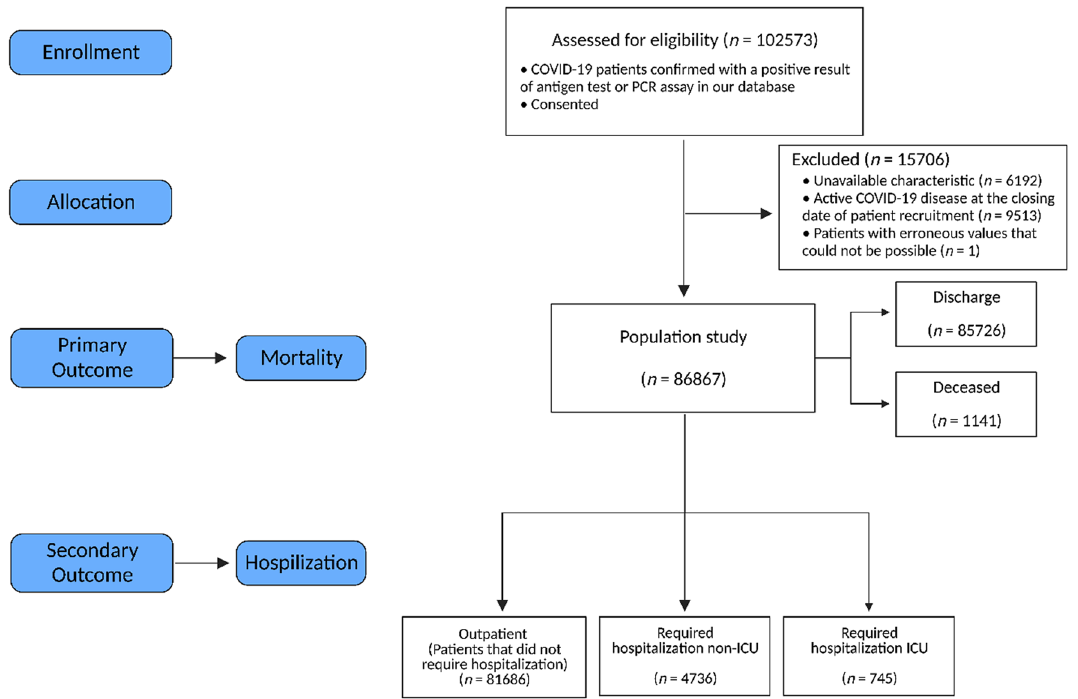
Figure 1. CONSORT diagram. Flow diagram of the enrollment of subjects, disposition status, and how they are analyzed in the study.